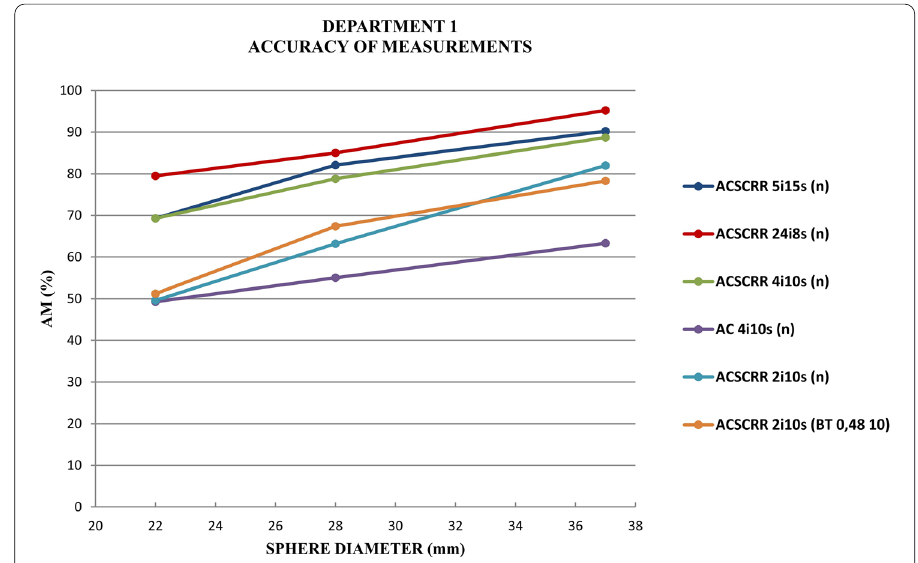
Fig. 5 Accuracy of measurements for activity in the 3 largest spherical inserts of the NEMA/IEC Body Phantom scanned with Discovery NM/CT 670 gamma camera in Department 1